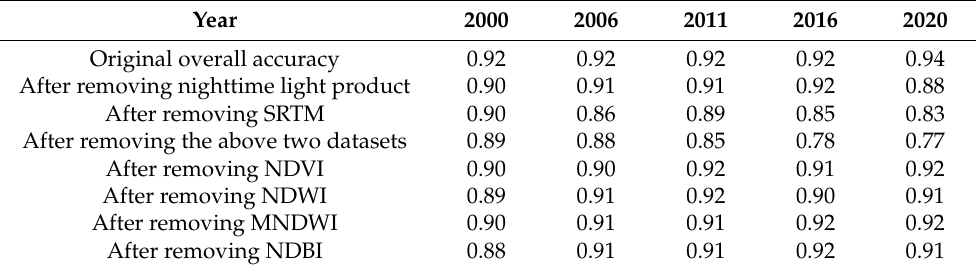
Table 8. Influence of several kinds of datasets on the overall accuracy of